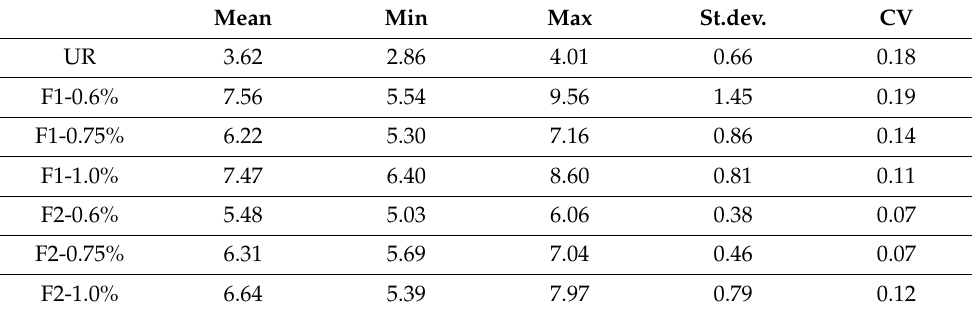
Table 7. Statistical data of the 3PBTs. CV is the coefficient of variation.